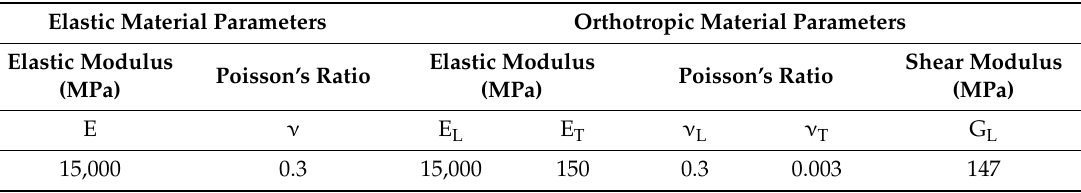
Table 1. Material parameters used in finite element method (FEM).